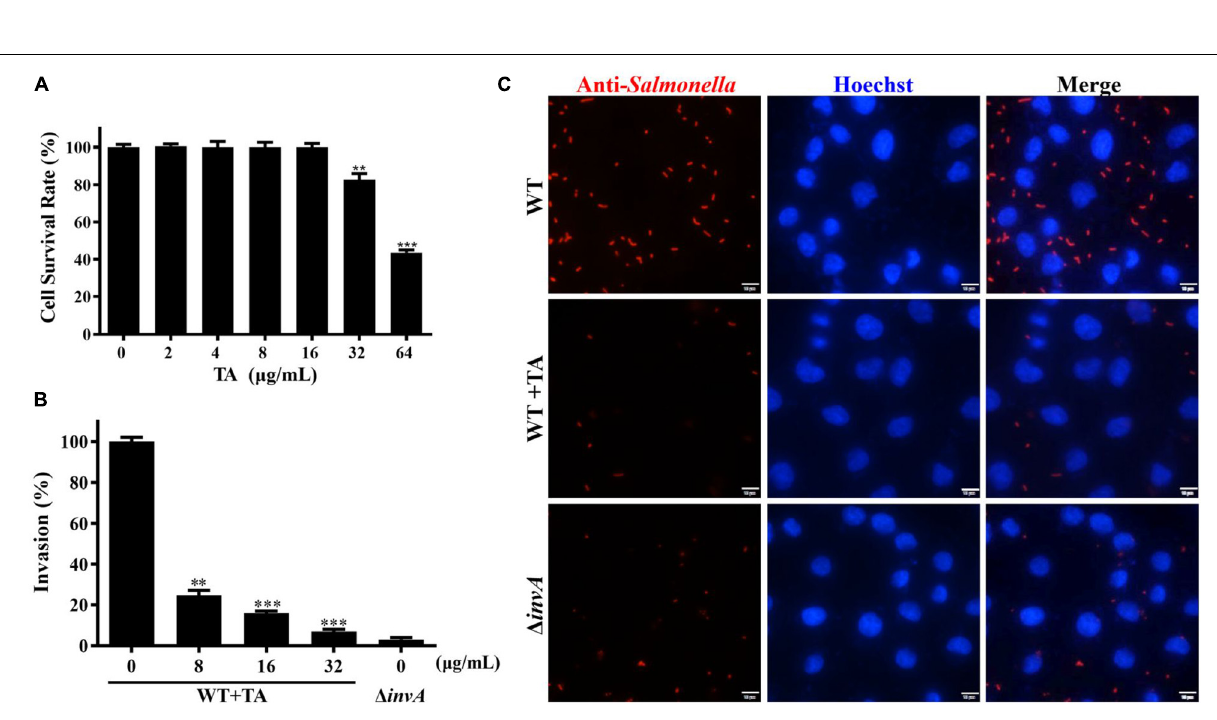
FIGURE 2 | Tannic acid inhibits the invasion of S. Typhimurium into HeLa cells. (A) The cytotoxity of TA to HeLa cells. (B) The effect of TA treatment on the invasion of S . Typhimurium into HeLa cells. (C) Immunofluorescence analysis for the effect of TA on the invasion of S . Typhimurium into HeLa cells (* p < 0.05; ** p < 0.01 and *** p < 0.001, Scale bar, 10 µ